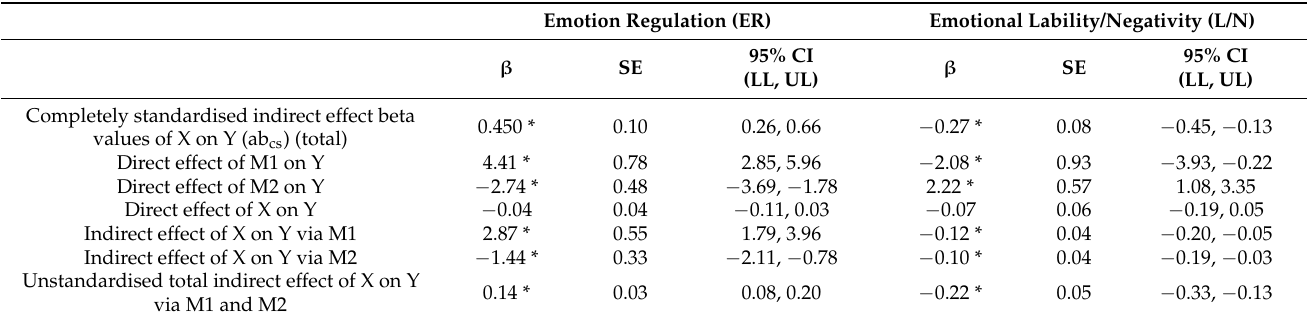
Table 7. Parallel mediation analysis examining indirect effects of child–dog attachment (X) on caregiver-reported emotion regulation (Y), via caregiver-reported positive child–dog behaviours (M1), and negative child–dog behaviours